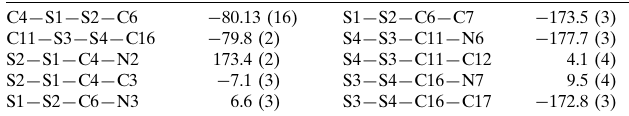
Selected torsion angles ( (cid:2) ).